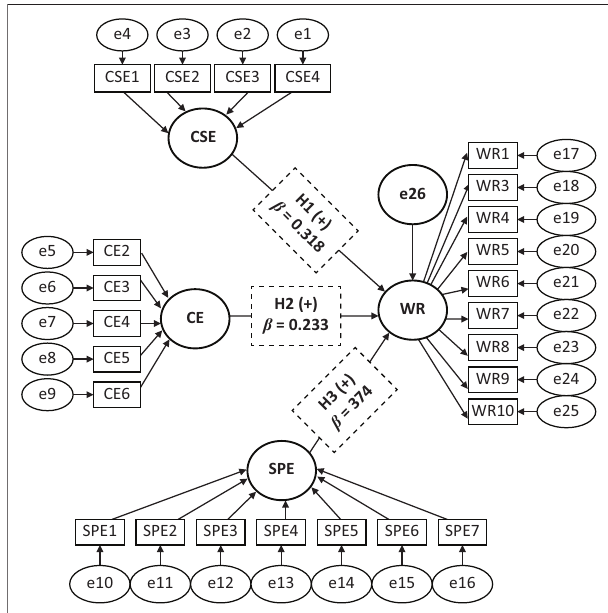
FIGURE 2: Structural TABLE 5: Summary of hypotheses testing. Relationships Hypothesis